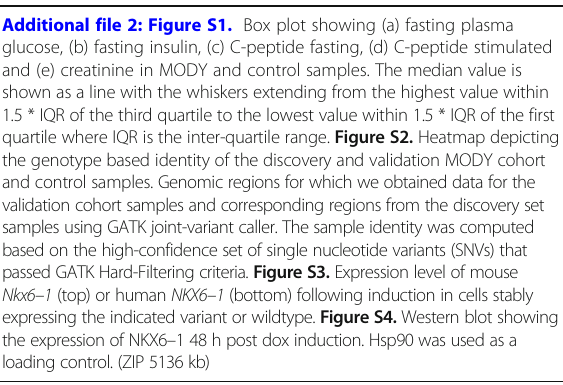
Table S3. Targeted gene panel. Table S4. Candidate variants identified in MODY samples. Table S5. Differentially expressed genes - NKX6 – 1 (XLS 292